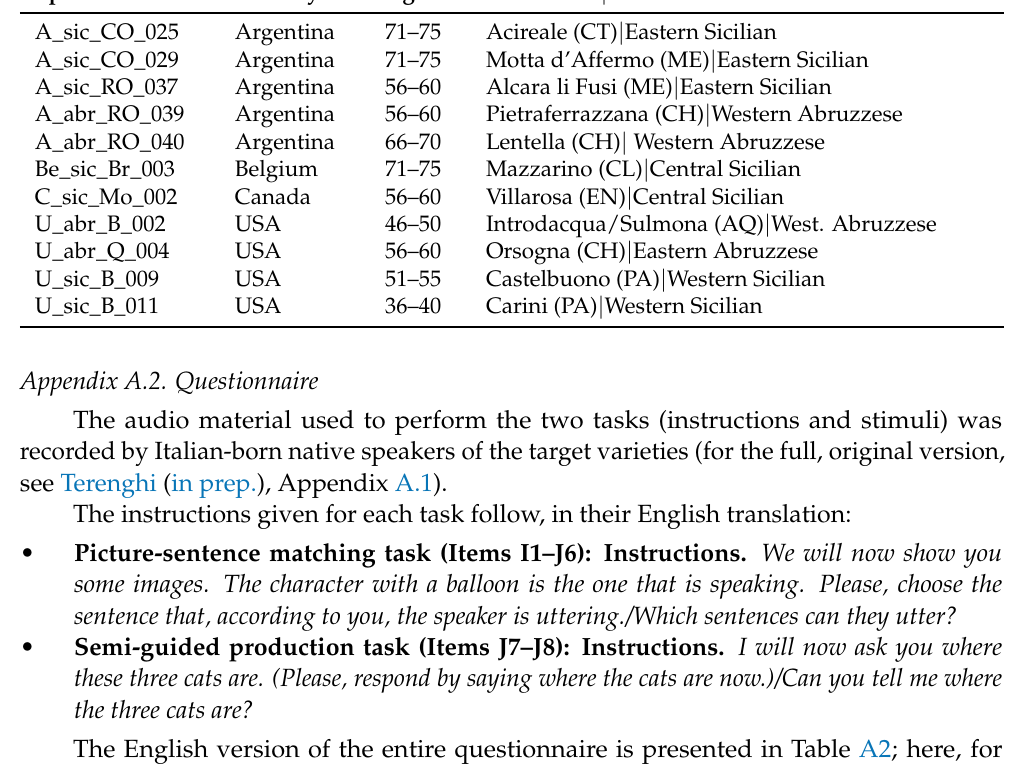
Figure 1a; audio: ‘{1/2/3} is my dog ’ 1 DEM .2 Figure 1b; audio: ‘{1/2/3} is your dog ’ 2 Figure 1c; audio: ‘{1/2/3} is their dog ’ 3 Figure 1a; audio: ‘{1/2/3} dog is mine ’ 1 DEM .2 Figure 1b; audio: ‘{1/2/3} dog is yours ’ 2 Figure 1c; audio: ‘{1/2/3} dog is theirs ’ Figure 1a; audio: ‘{1/2/3} here is my dog ’ 1 Figure 1b; audio: ‘{1/2/3} there 2 is your dog ’ 2 Figure 1c; audio: ‘{1/2/3} there 3 is their dog ’ 3 Figure: three cats in the room; audio: Which one is the black/orange/white cat? Figure: three cats in the room; audio: Where is the black/orange/white cat?